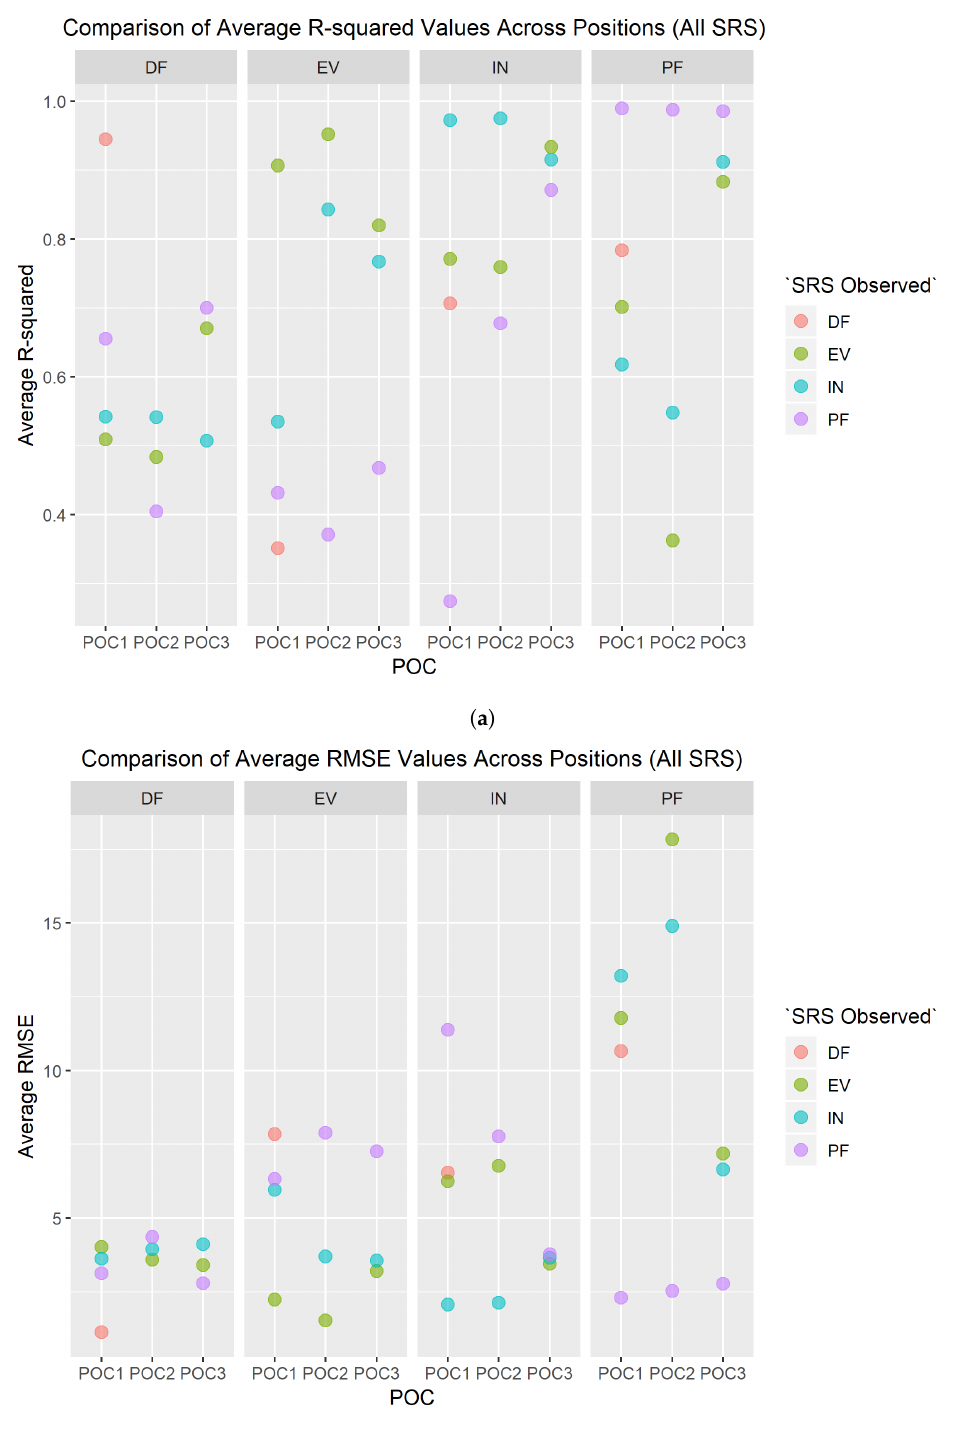
Figure 11. Comparison of R 2 and RMSE values: ( a ) comparison of average R 2 values for all SRS at all POCs; and ( b ) comparison of average RMSE values for all SRS at all POCs. Note that in both comparisons DF only had one SRS